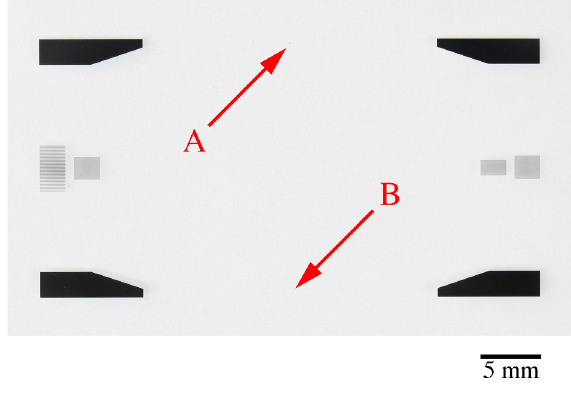
Figure 3. Pictures of the fi nal two circular phase-shift masks obtained in the fabricated element. The images were obtained with a DIC microscope in a transmission con fi guration with a / 0.9 Nikon TU Plan Fluor 100 ×